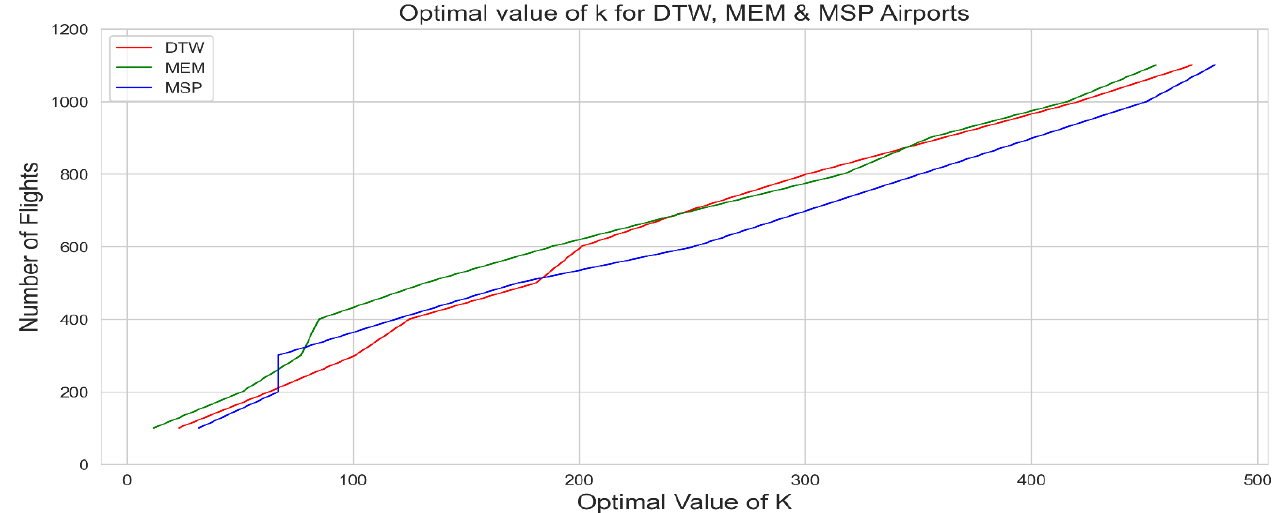
Figure 7. Optimal k vs. number of flights for three airports.